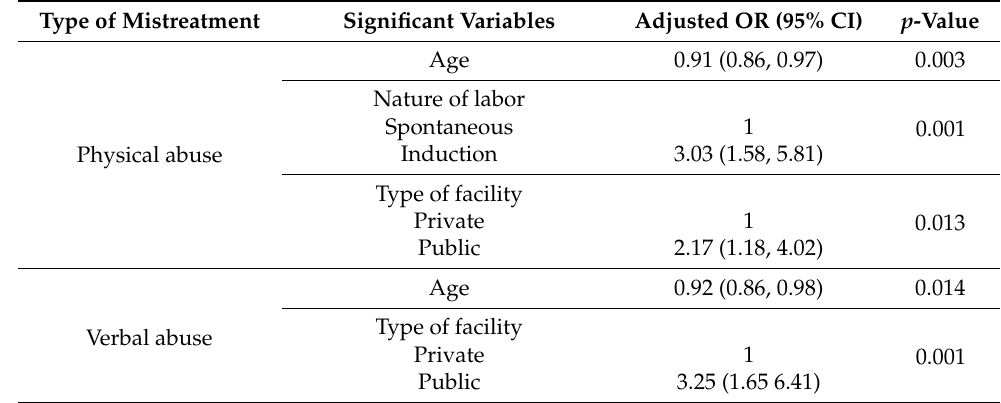
Table 6. Multiple logistic regression analysis of factors associated with each type of